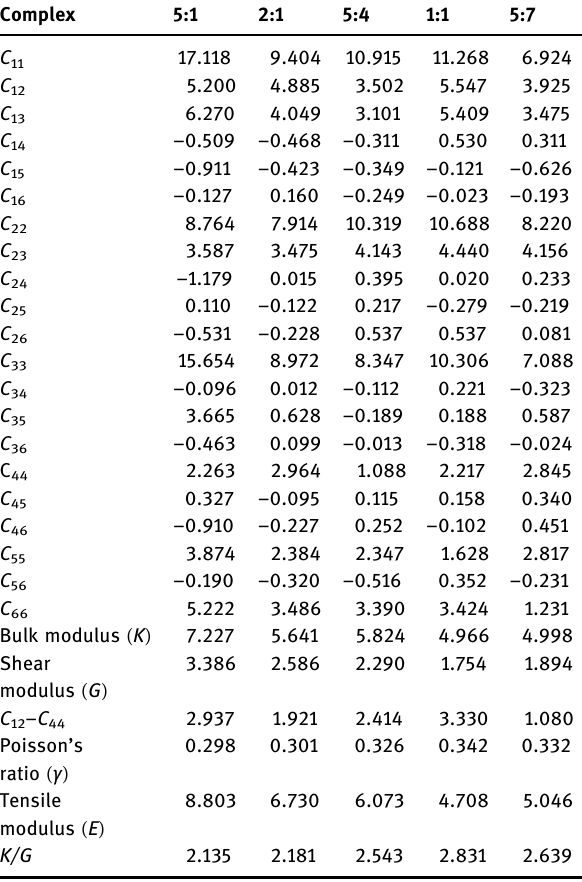
Table 2: Mechanical properties of CL - 20/NQ cocrystal models with di ff erent molecular ratio a [ 79 ]